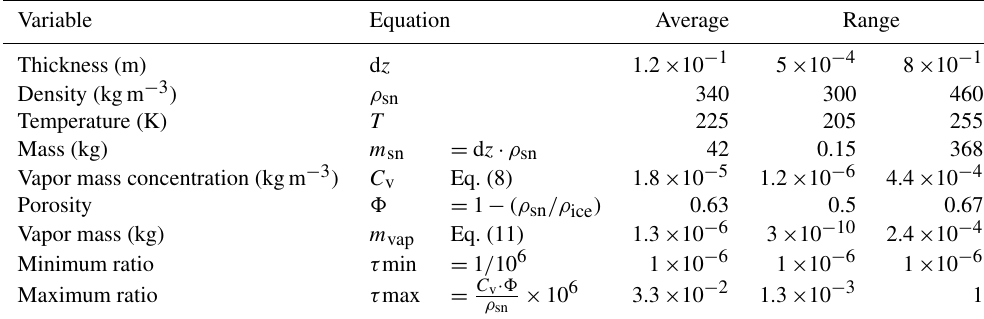
Table 3. Typical thickness, density, temperature, and other parameters of the snow layers in the simulations. The ratio τ is the mass ratio between the grain surface compartment and the grain center compartment. It must be chosen within the interval [10 − 6 ; 10 6 ( C v (cid:56)/ρ sn ) ] to allow for exchanges between the grain surface compartment and grain center compartment on the one hand and between the grain surface compartment and vapor compartment on the other hand (see text for